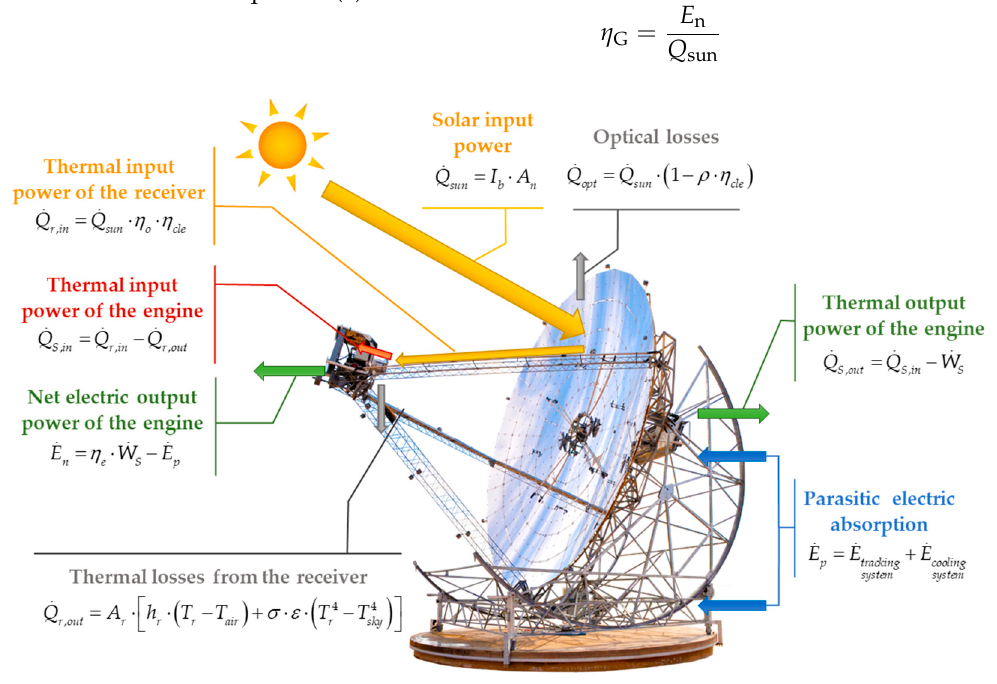
Figure 1. Scheme of the energy balance of a dish-Stirling concentrator.